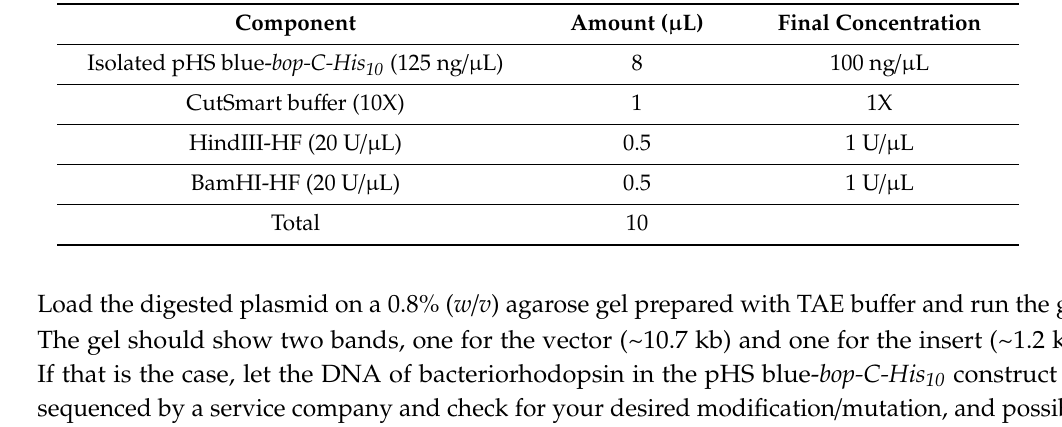
Table 6. Reaction mixture for the digestion of the amplified